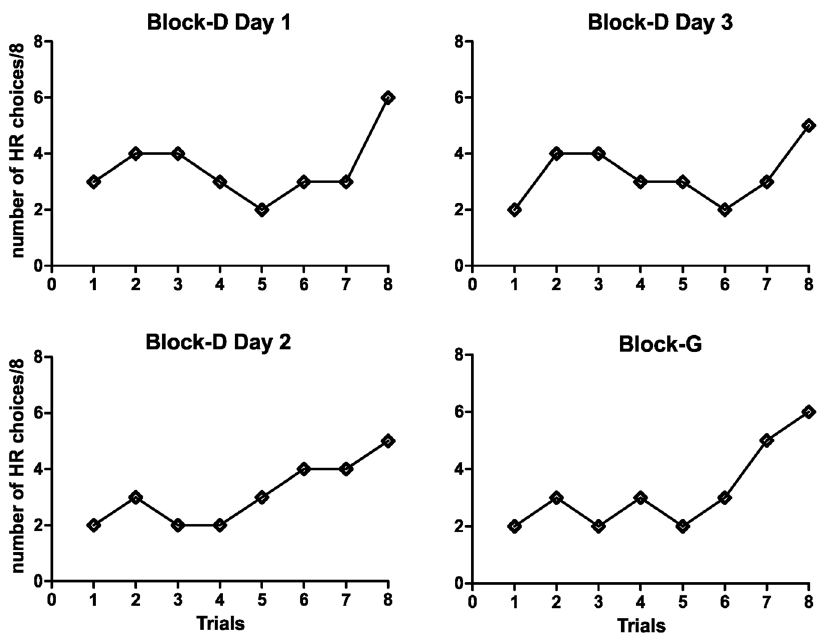
Figure 3. Behavioural strategy changes were evident from the first trial. When highly fatigued (blocks D and F), mice of the Exp group showed a clear preference for LR (thus, a reversal of choice from HR to LR) from the very first trial every day, corroborating the idea that they were performing a cost-benefit computation rather than learning to avoid the costly HR choice by trial and error. The graph also shows that this preference for LR was maintained (on average) until the 8 th trial, suggesting that this was a good window to investigate the